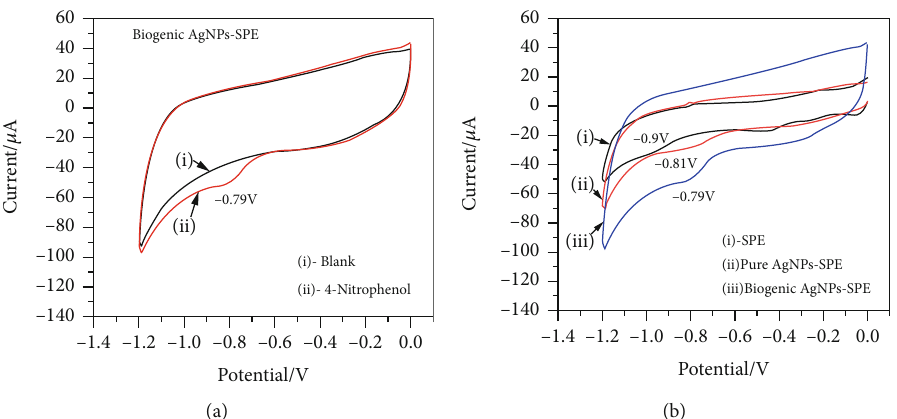
Figure 6: CV of (a) 10 μ M 4-NP at biogenic AgNPs-SPE in 0.1M PBS (pH7.4); (b) 10 μ M of 4-NP at bare SPE, pure AgNPs-SPE, and biogenic AgNPs-SPE in 0.1M PBS